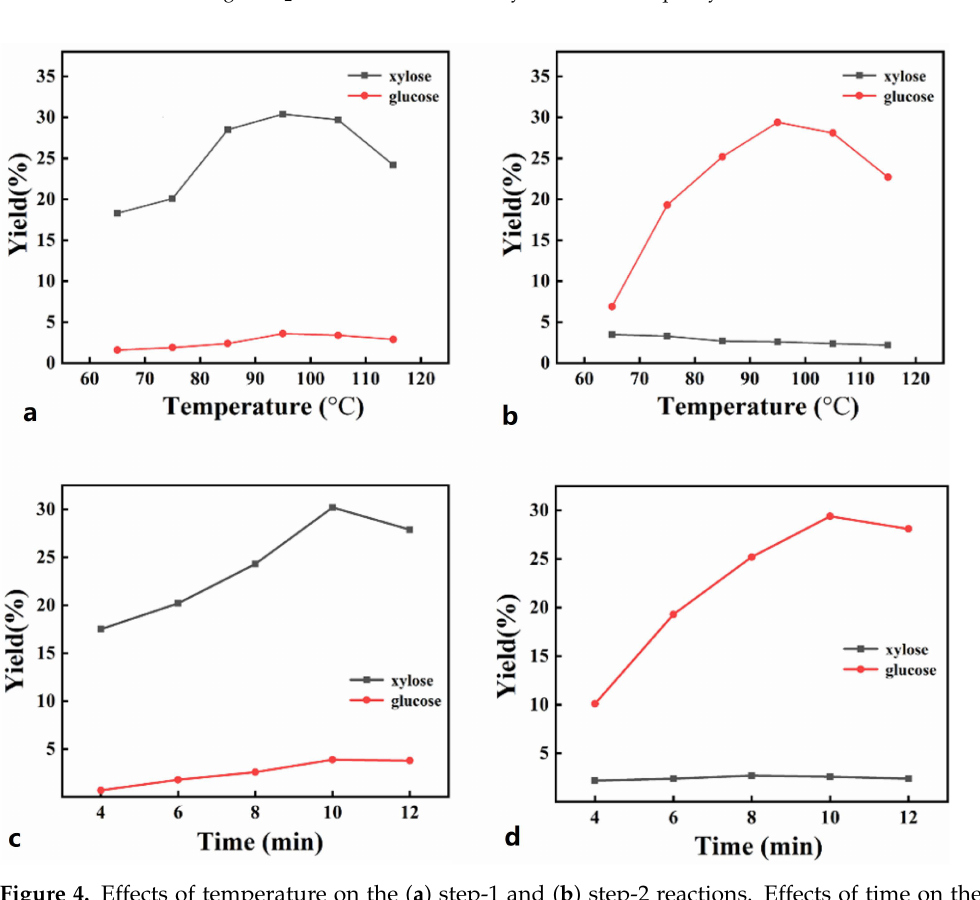
Figure 4. Effects of temperature on the ( a ) step-1 and ( b ) step-2 reactions. Effects of time on the ( c ) step-1 and ( d ) step-2